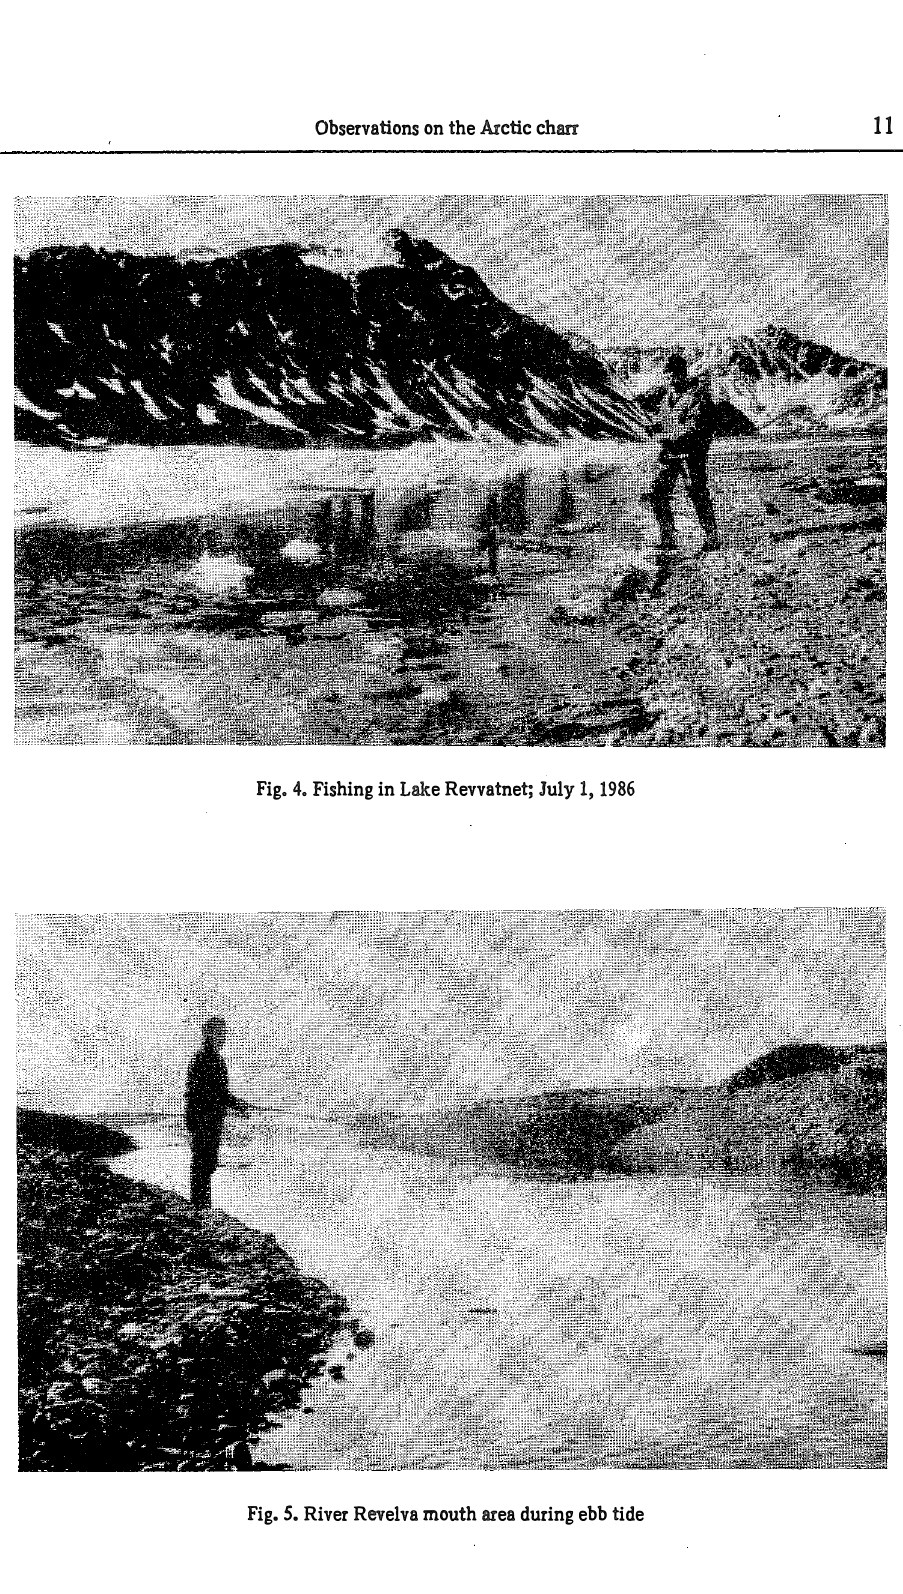
Fig. 5. River Revelva mouth area during ebb